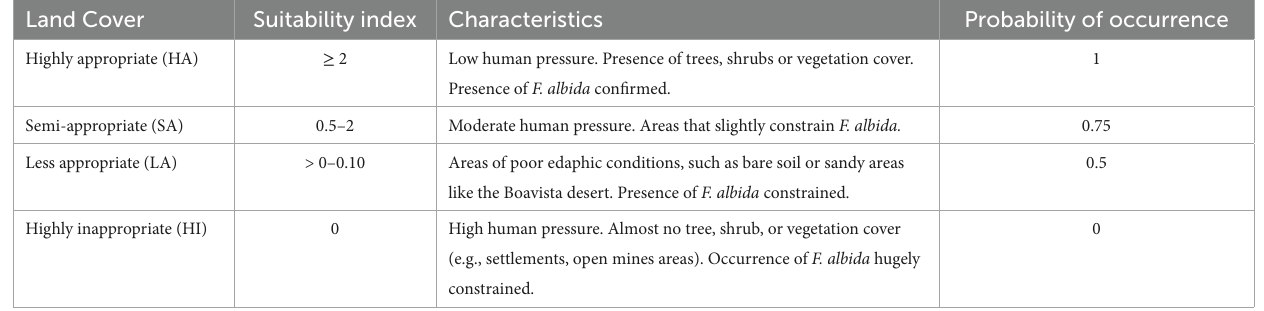
TABLE 2 Recategorization of the LULC index into the Suitability Index. Land Cover